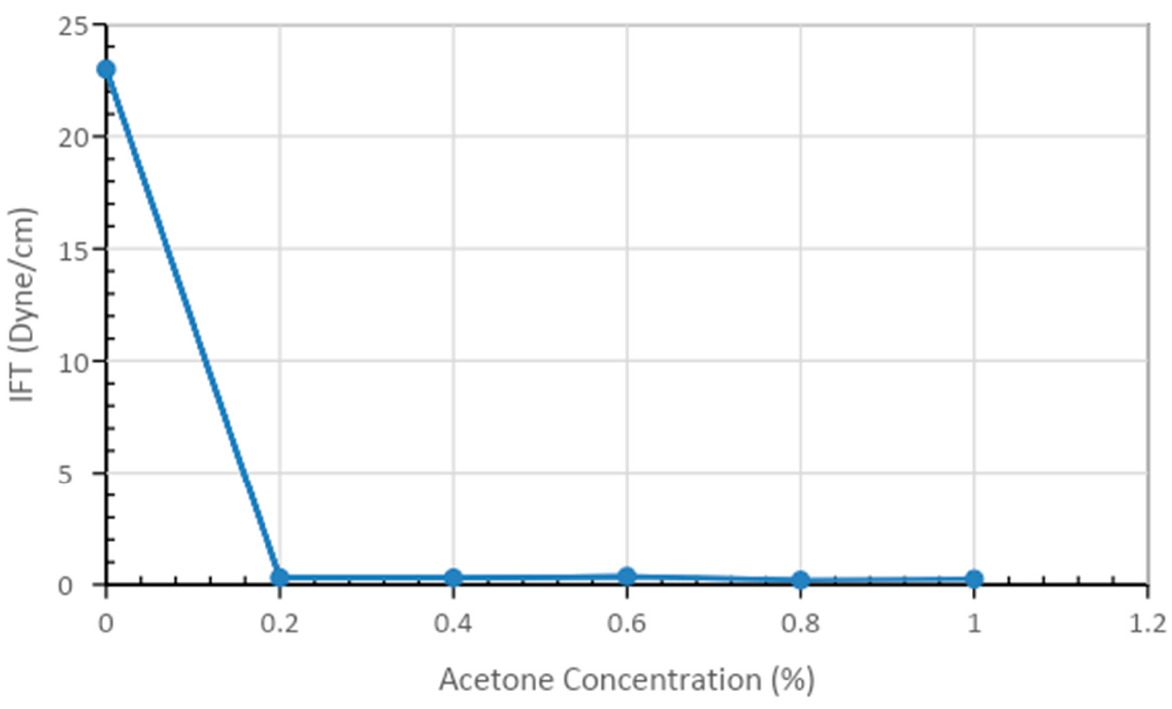
Figure 7. Interfacial tension values for the acetone at concentrations ranging from 0.20% to 1.00% with constant APG (0.50%) and brine (2% NaCl) levels at 52 ◦ C and atmospheric pressure. Table 5. Interfacial Tension Values for Solutions of Acetone (0.00%-1.00%), 0.50% APG, and 2% NaCl.